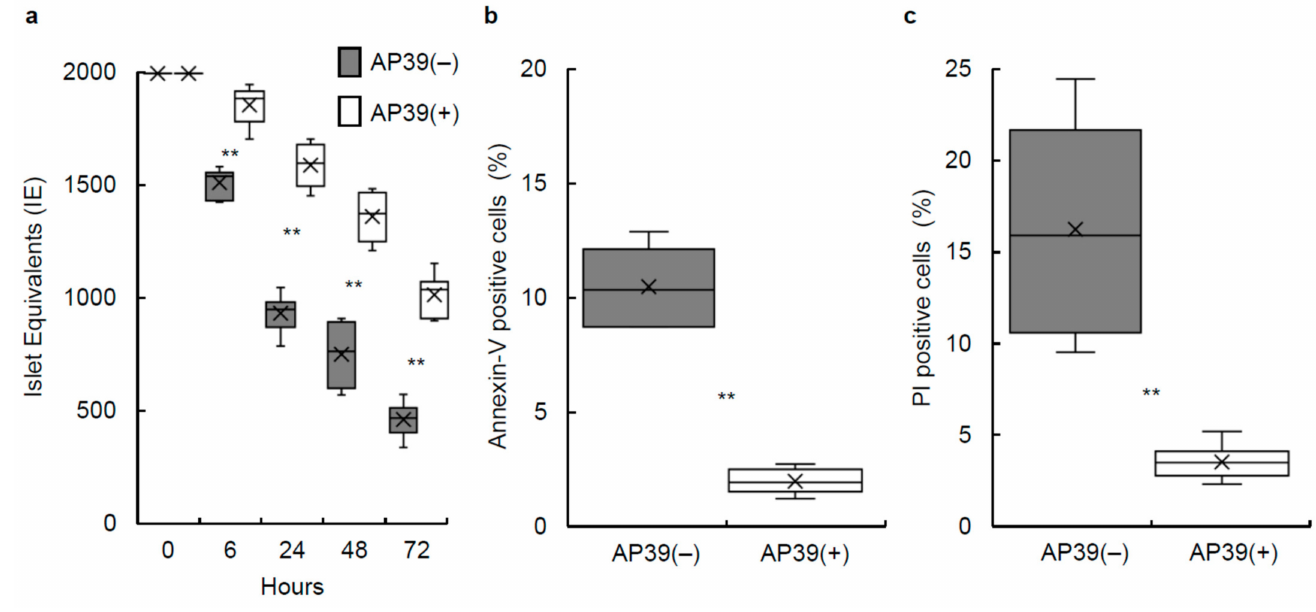
Figure 2. Effect of AP39 on cultured porcine islets. ( a ) Number of porcine islets after culture. 2000 IEs of porcine islets were cultured with 400 nM AP39 or without AP39 for 72 h. After 6, 24, 48, and 72 h of culturing with or without AP39, the islets were counted to calculate the IE ( n = 6 each). ( b , c ) Annexin V/propidium iodide (FDA/PI) staining of 24 h cultured islets. We dispersed 1000 total IEs of cultured islets with or without AP39 into single cells using Accutase and then incubated the single cells with FITC-annexin-V ( b ) and PI ( c ). AP39( − ) group: n = 6; AP39(+) group: n = 6. Data